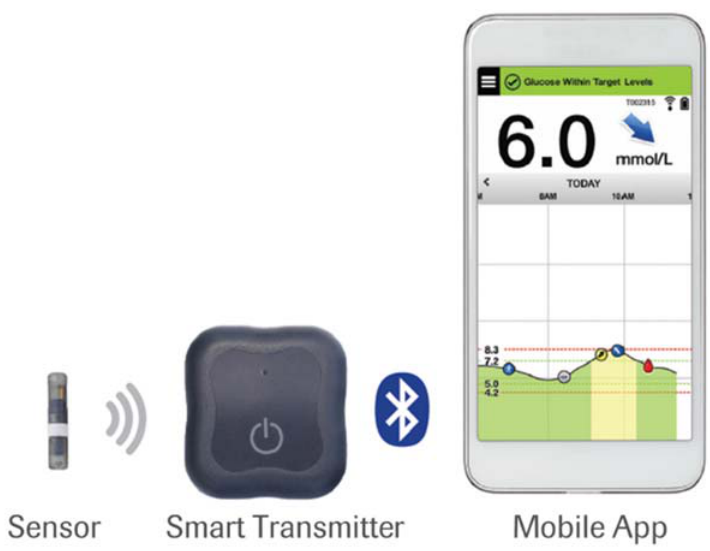
Figure 4. Example of implantable CGM system based on optical sensing technique, the Senseonics Eversense continuous glucose monitoring system (taken from [74]).